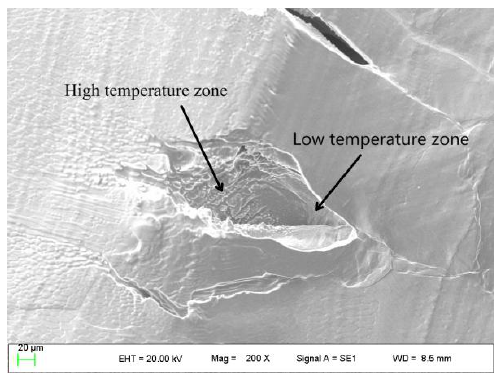
Figure 4. Typical morphology of a crack. Test material: 441 steel, test strain: 5%.